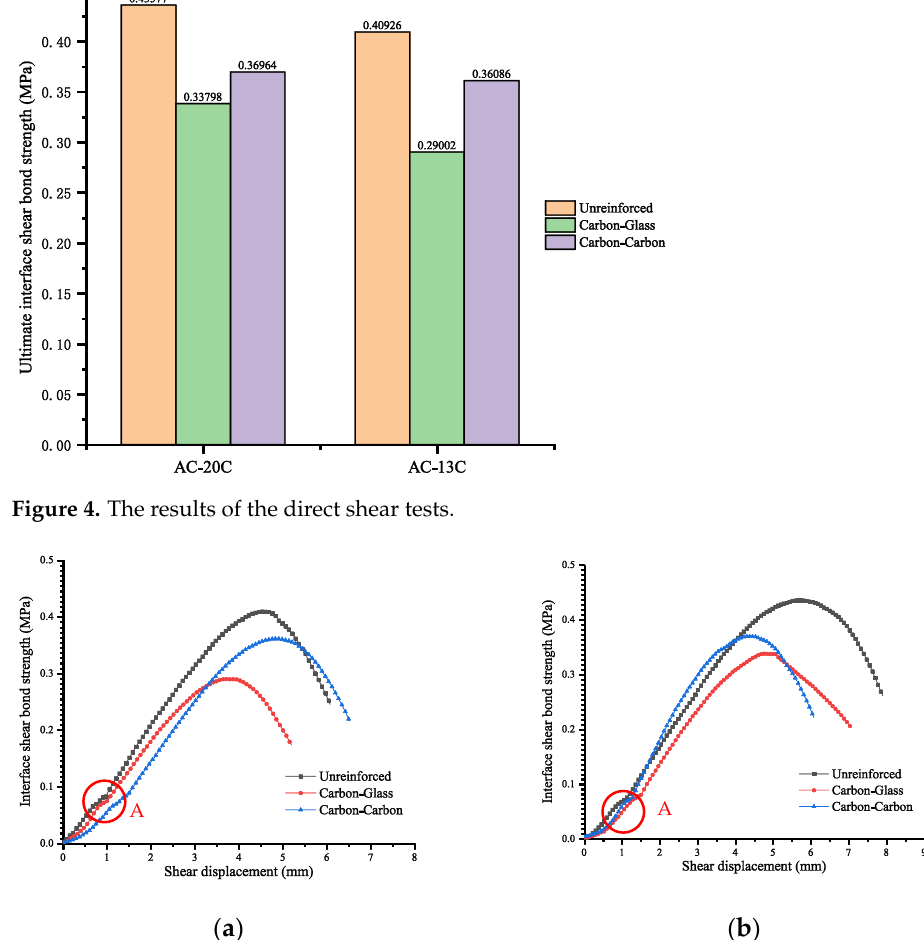
Figure 5. Interface shear strength vs. shear displacement curves in direct shear experiment. ( a ) AC-13C and ( b ) AC-20C